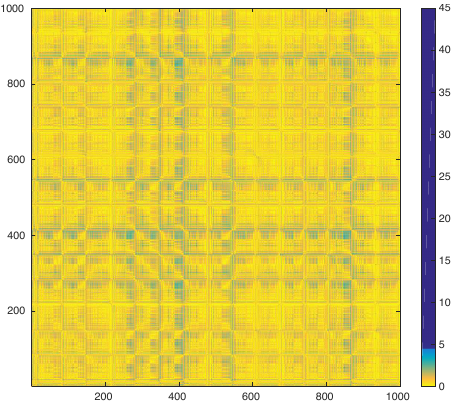
Figure 12: Non-specific bivariate leakage detection test on 15 clock cycles of a second-order protected AES with 50 million traces.